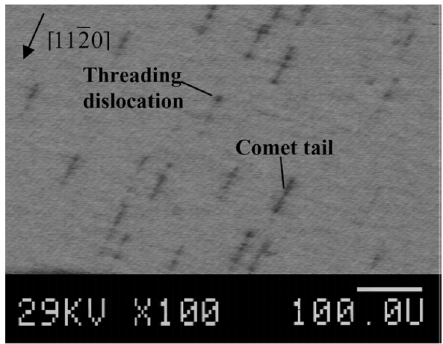
Figure 16. Electron beam induced current spectroscopy (EBIC) image of a n-type 4H-SiC epitaxial